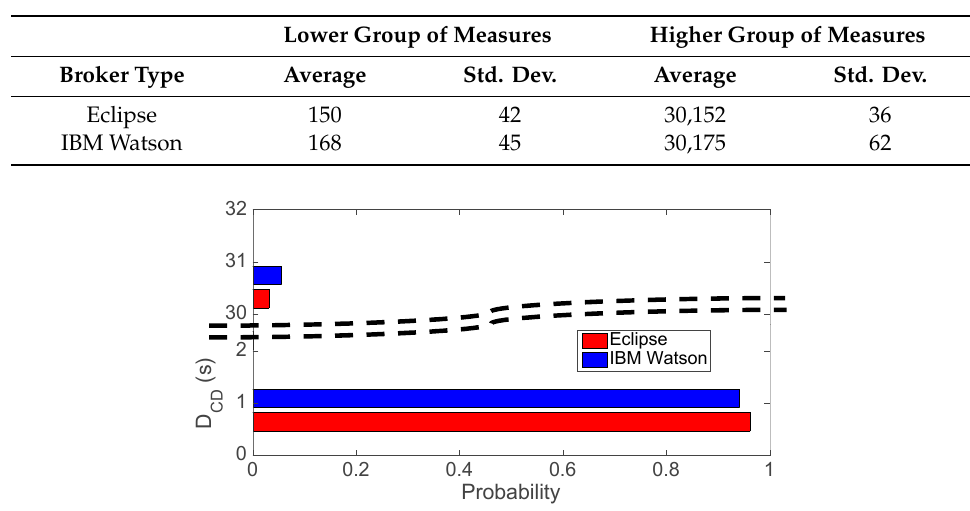
Figure 4. Distribution of the D CD metric during the experiments. There are two groups, the distribution is bimodal.